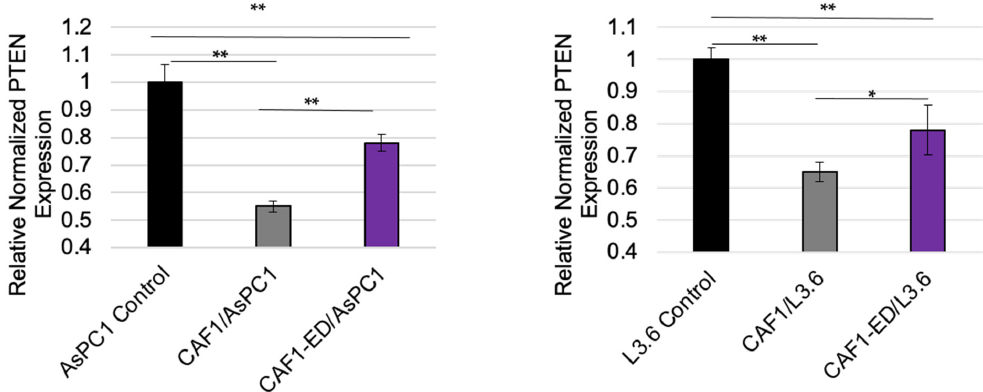
Figure 2. PTEN expression in cells where exosomes are retained or depleted from CAF-derived media. PTEN expression was analyzed via RT-PCR in AsPC1 cells (left) or L3.6 cells (right) after cultured in normal DMEM or RPMI (control), CAF-conditioned media, or exosome-depleted CAF-conditioned media (CAF1-ED) each day for four days. ** p < 0.01. * p <